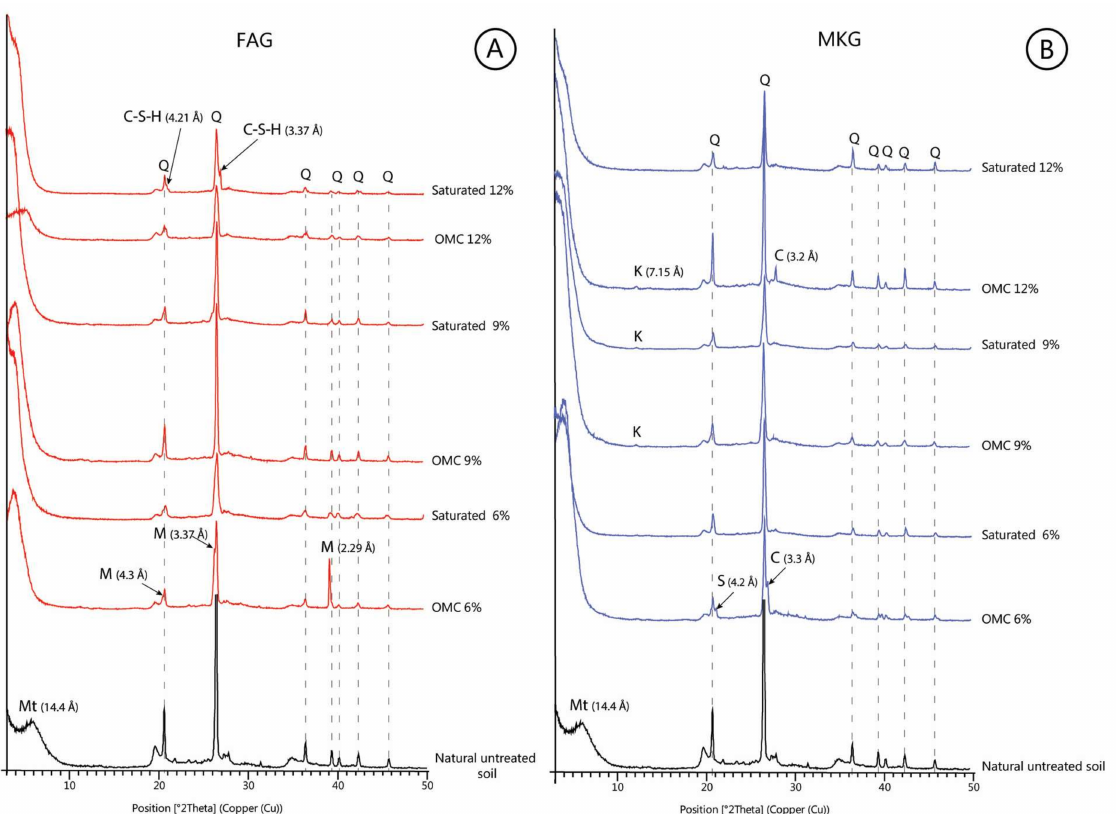
Figure 5. The XRD patterns of samples stabilized with different percentages of FAC and MKG at OMC and saturation conditions compared with the natural untreated sample ( a ) FAC-stabilized samples and ( b ) MKG-stabilized samples. Mineral abbreviations: M: mullite, Mt: montmorillonite; Q: quartz;